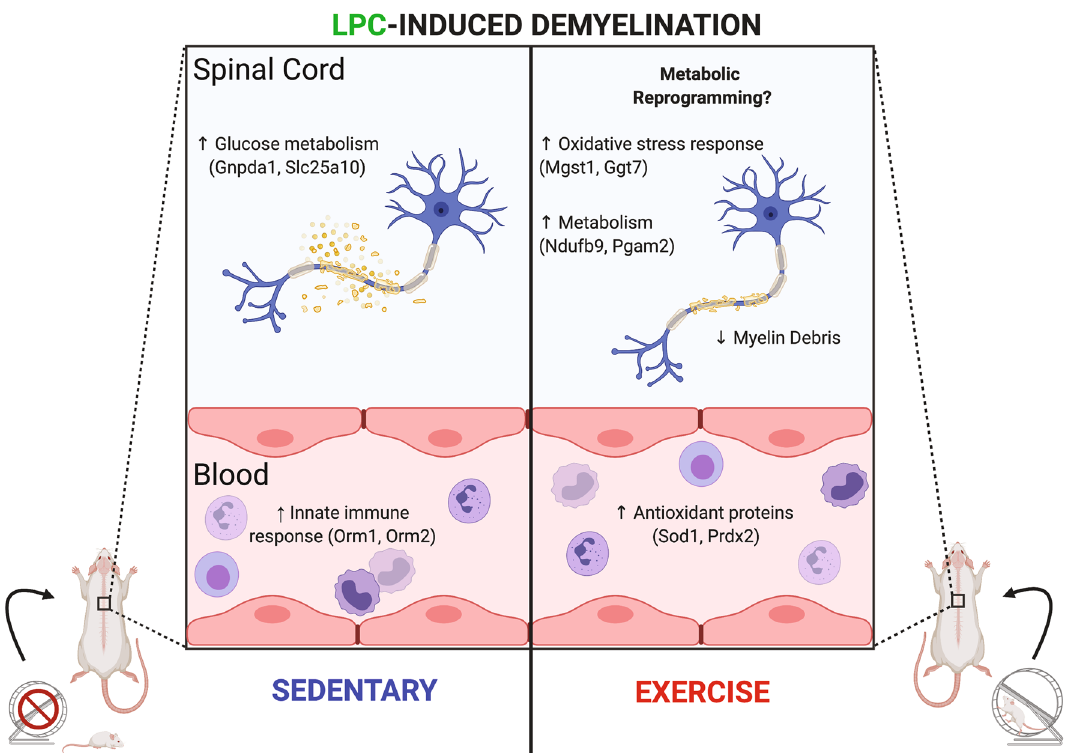
Figure 8. Schematic representation of key protein changes between naïve and LPC mice that underwent 4 days of exercise or remained sedentary. Figure was drawn using